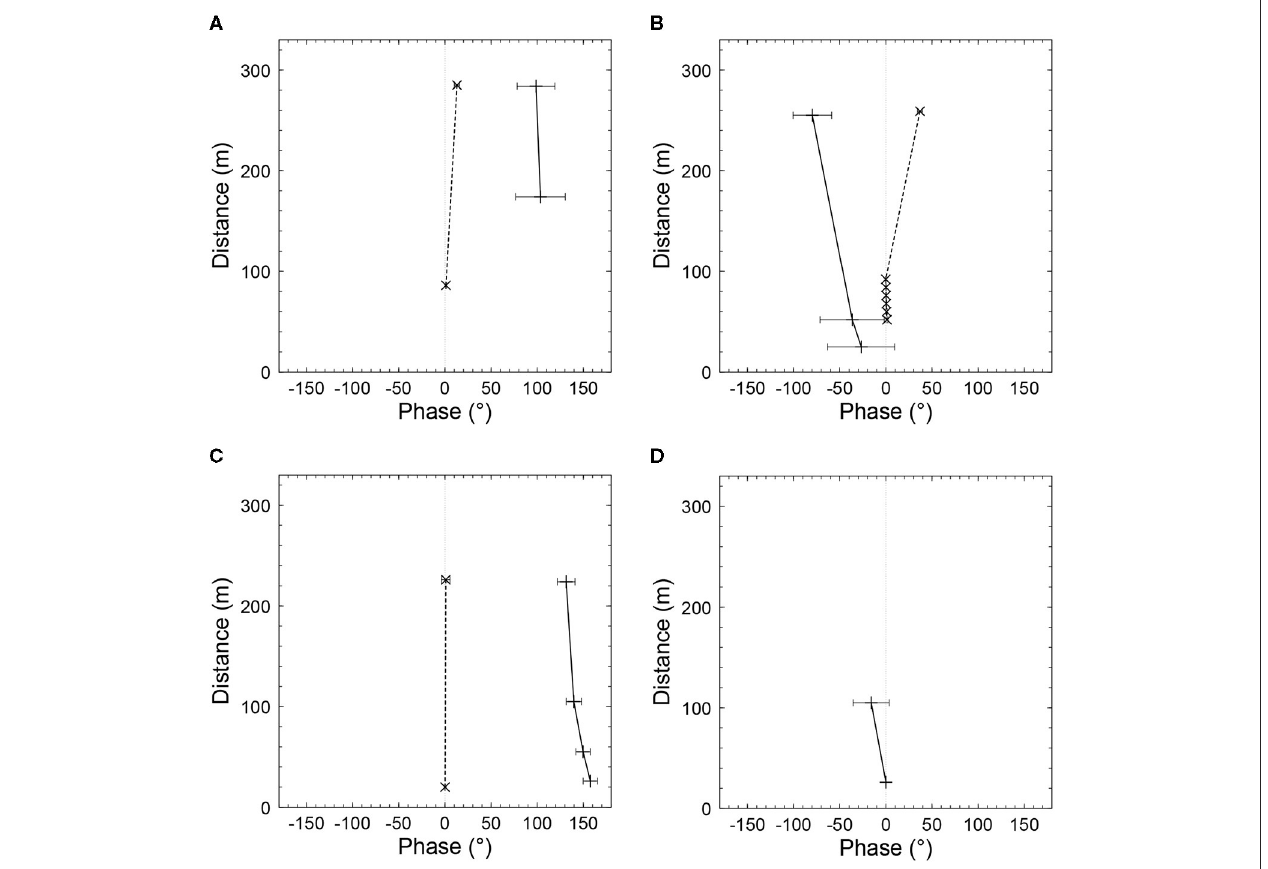
FIGURE 13 | Vertical distribution of the phase of potential temperature (solid line and pluses) and u maj (dashed line and crosses) at moorings (A) M1, (B) M2, (C) M3, and (D) M4. The phase in the frequency band of 0.094–0.156, 0.25–0.313, 0.25–0.313, and 0.156–0.234 cpd is shown for moorings M1, M2, M3, and M4, respectively. The vertical axis indicates the height from the bottom. The horizontal bars indicate the 95% confidence limit of the phase. The symbols are not drawn at depths where the 95% confidence limit exceeds 60 ◦